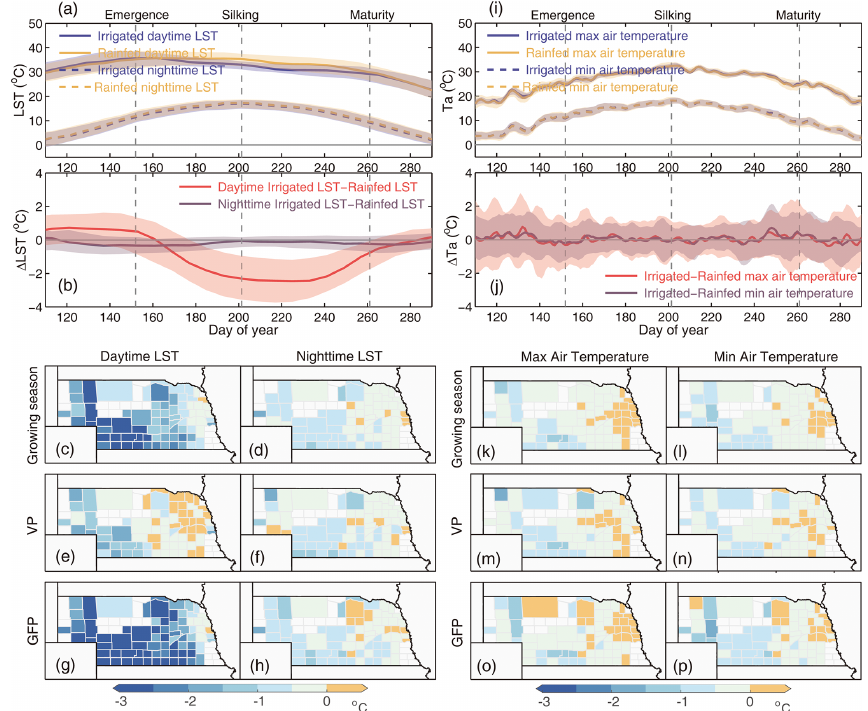
Figure 3. Spatial–temporal patterns of daytime and nighttime MODIS LST differences (a–h) and surface air temperature differences (i–p) between irrigated and rainfed maize in different growth stages: vegetative period and grain filling period. The shaded areas in (a) , (b) , (i) , and (j) show 1 standard deviation of corresponding